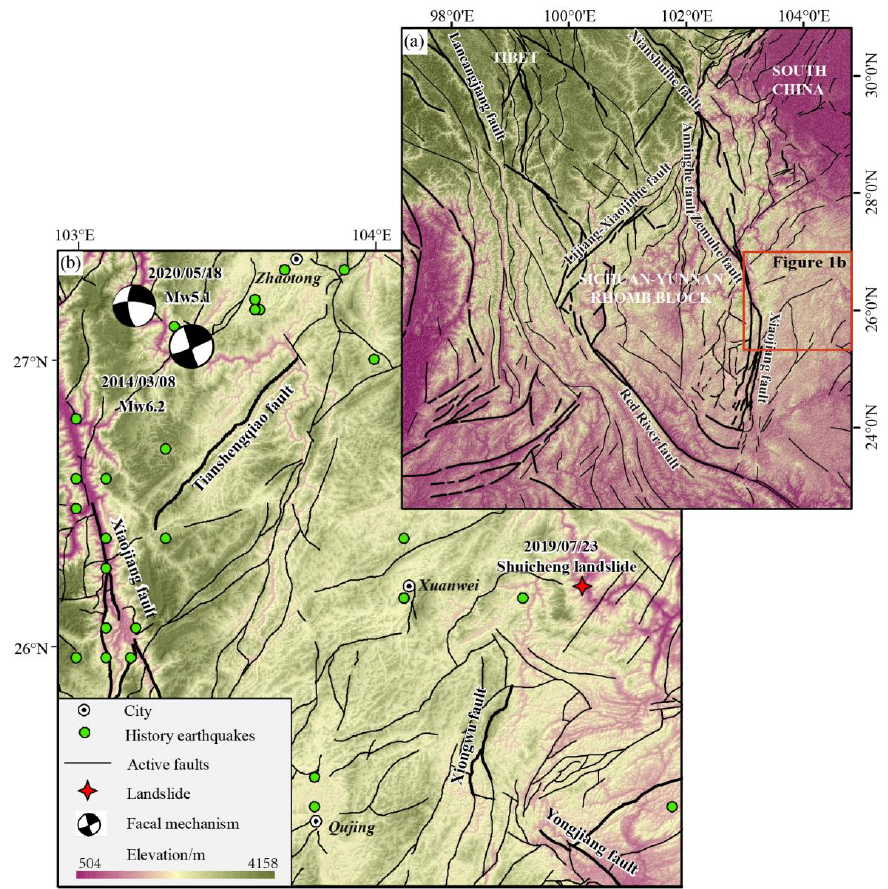
Figure 1. Tectonic setting in the Shuicheng landslide area. ( a ) Simplified tectonic map of the southeast Tibetan plateau and adjacent regions. The red box is the range of ( b ). ( b ) Detailed tectonic setting and historical earthquakes around the Shuicheng